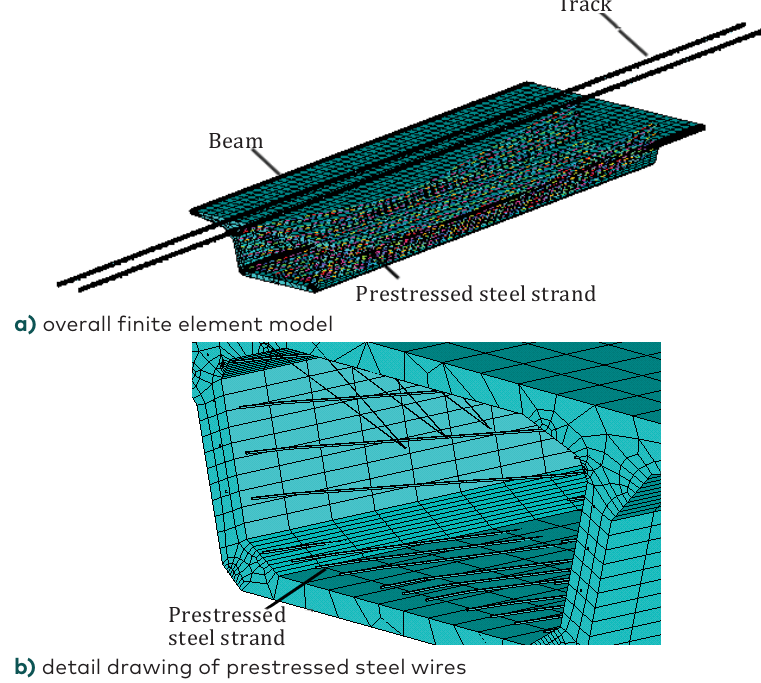
Figure 3. Finite element model of bridge-track system